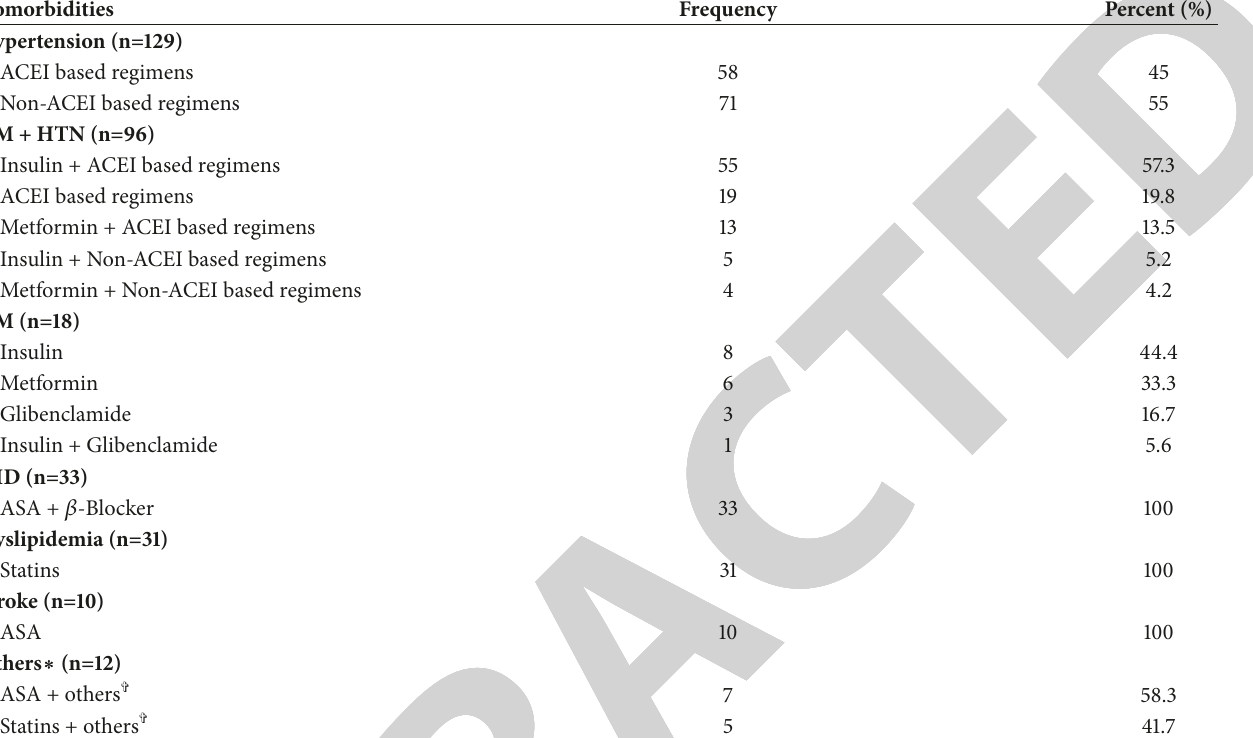
Table 6: Types of regimens used in the management of chronic kidney disease comorbidities patients attending the renal clinic of Tikur Anbessa Specialized Hospital. Comorbidities